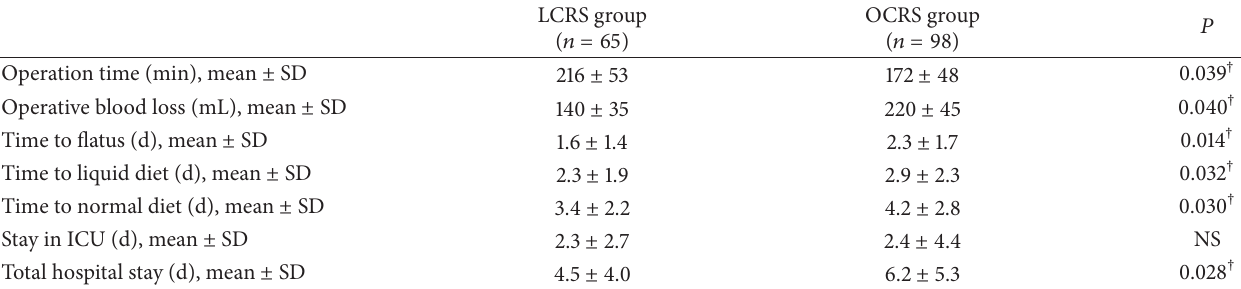
Table 2: Operative and postoperative results of the two patient